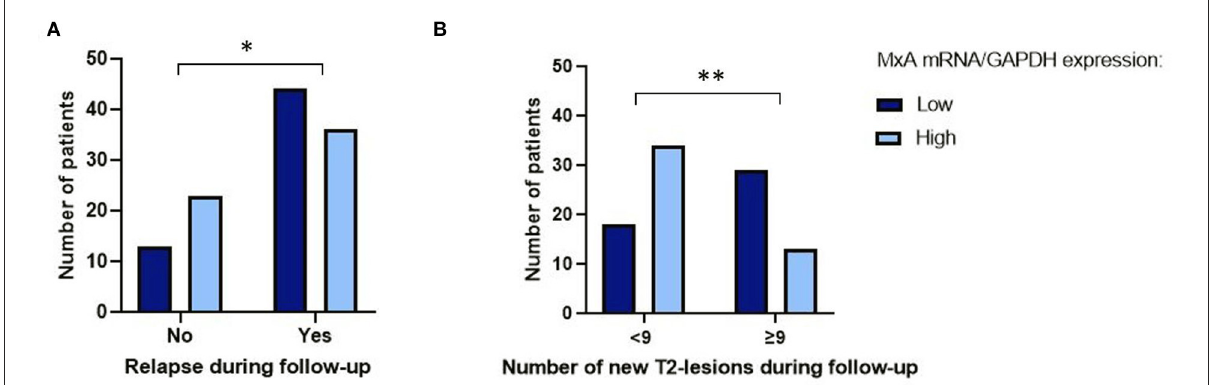
FIGURE1 Baseline MxA mRNA level vs. occurrence of relapses and new T2-lesions on MRI during follow-up. (A) Number of patients with low vs. high MxA mRNA/GAPDH expression that experience at least one relapse during follow-up. *Results of logistic regression analysis: B = − 0.81, Exp(B) = 0.45, p = 0.070, 95% CI 0.19–1.07. (B) Number of patients with low vs. high MxA mRNA/GAPDH expression that have < 9 vs. ≥ 9 new T2-lesions on MRI during follow-up. **Results of logistic regression analysis: B = − 1.86, Exp(B) = 0.16, p = 0.012, 95% CI 0.04–0.66. All patients